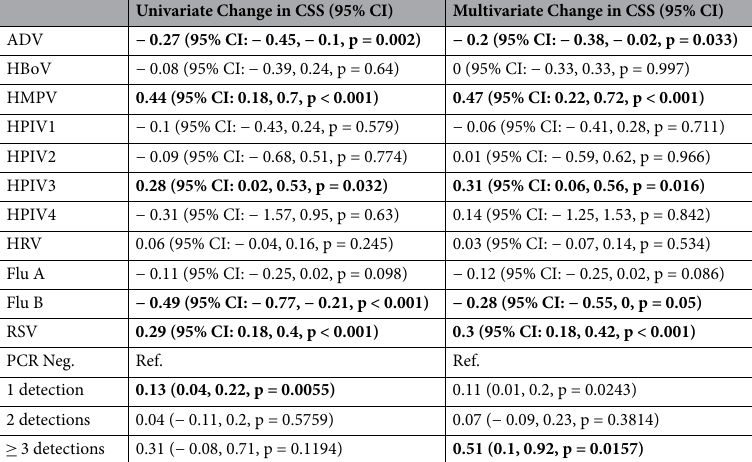
may be that infection with one pathogen enhanced the severity of a subsequent infection leading to hospitaliza- tion with the first infection cleared. We are unable to detect enhancing infections of this type, and hence may under-estimate the clinical role of viral co-infection. We do not have information on subsequent admission to the